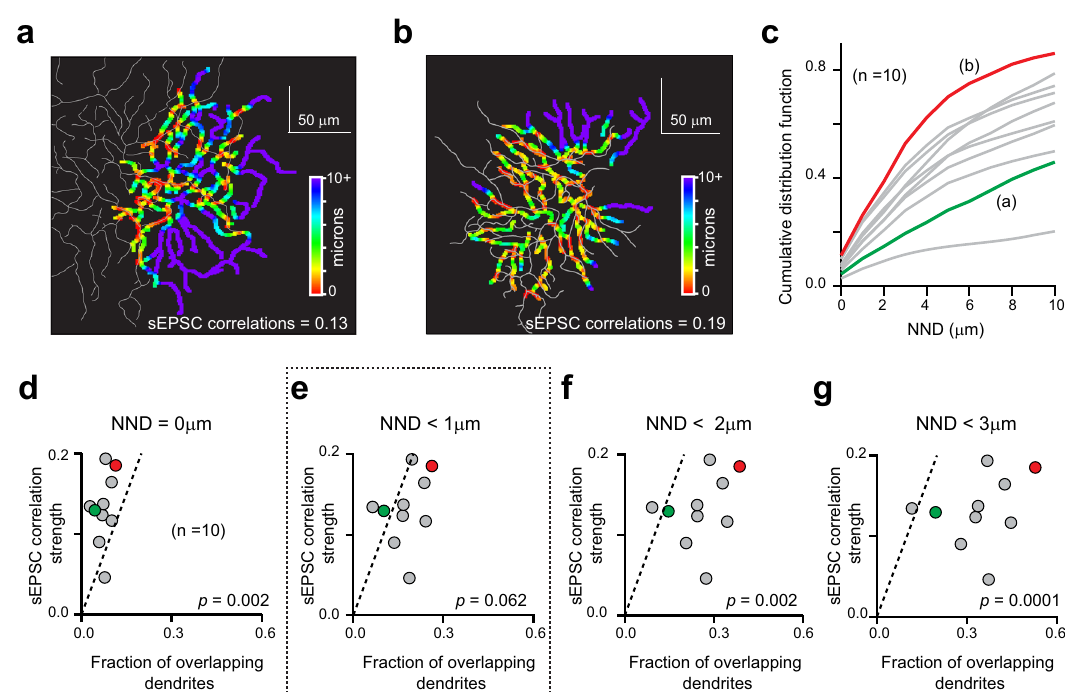
Fig. 3 Structure/function correlations suggest that quantal ACh signals are mediated over a broad spatial scale (~1 μ m). a Reconstructions of the OFF dendritic arbors of two DSGCs. For illustrative purposes the dendritic arbor for one of the DSGC is thickened using a 3 × 3 average fi lter and color-coded to indicate the nearest neighboring dendrite distance (NND; see text). For simplicity, the maps of the ON arbors are not shown. NNDs were computed for 1 μ m dendritic segments. The strength of the correlation between sEPSCs recorded in this pair of DSGCs is indicated at the bottom. The correlation strength was quanti fi ed as the ratio of the peak amplitudes of the STA and average sEPSC. b Similar to ( a ), but for a different pair of DSGCs with greater dendritic overlap and higher correlated activity. c Cumulative distribution functions of NNDs for all the segments in each DSGC ( n = 10 DSGCs from 5 pairs). Green and red traces indicate the distributions for the DSGCs shown in ( a and b ), respectively. d – g Comparison of the correlation strength of the sEPSCs recorded in DSGC pairs to the fraction of overlapping dendrites (calculated from the NND distribution; see methods), for four different distances (0, 1, 2, and 3 μ m; dotted line is the unity line). The colored data points indicate the values obtained from the DSGC pairs shown in ( a and b ). The overlap in dendrites is only predictive of the correlation strength when the fraction of dendrites within 1 μ m is considered ( e ). This indicates that correlated ACh signals are mediated at dendritic crossings within ~ 1 μ m of each other suggesting the tripartite complex (Fig. 1d, e) as the synaptic substrate. p indicates the level of signi fi cance for paired t tests. Source data are provided as a Source Data fi le for Fig. 3c –